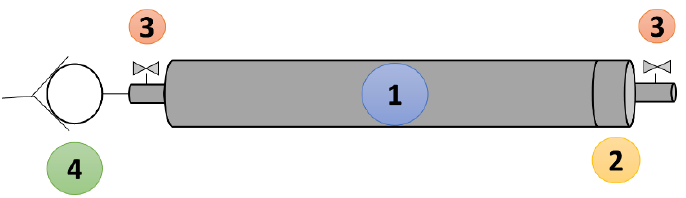
Figure 1. Schematic of the high-pressure sampler. (1) 1 L stainless-steel tube, (2) screwed stainless-